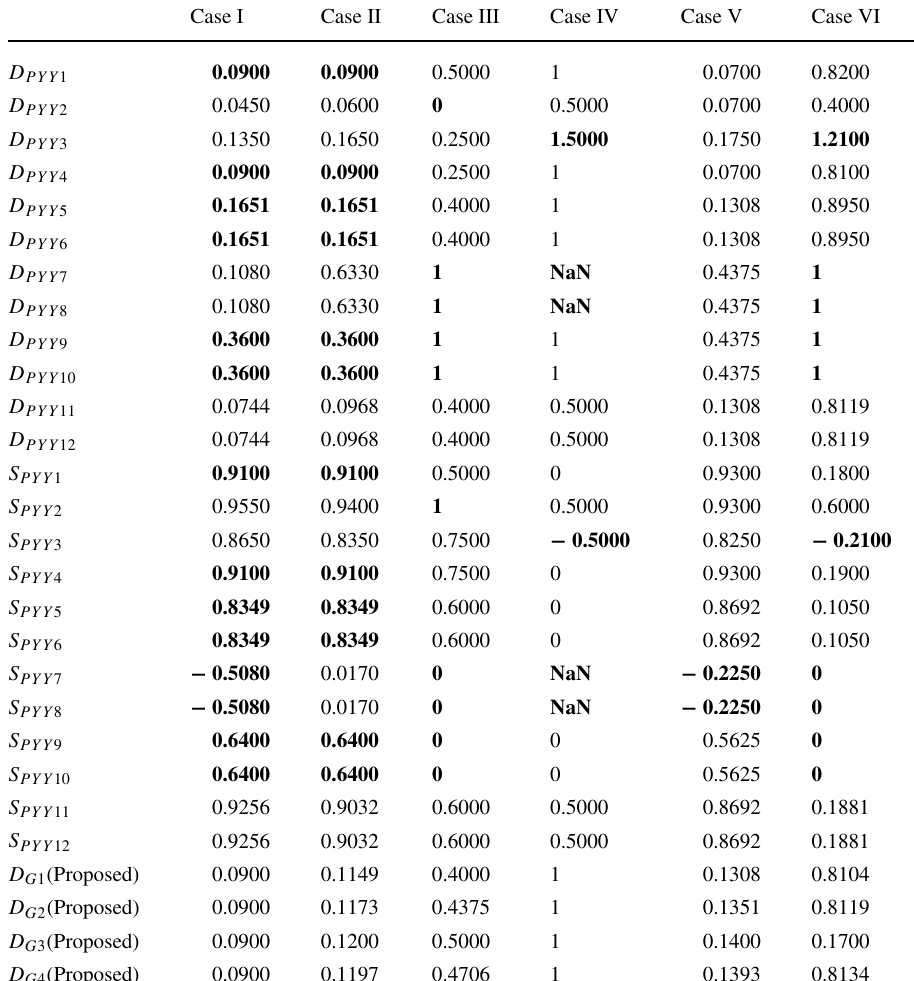
Table 6 Computed values of various PF distance/similarity measures regarding Example